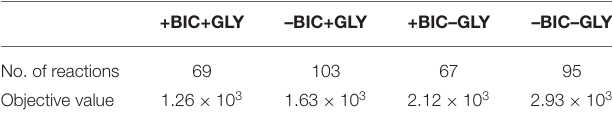
TABLE 1 | Objective value and number of reactions in linear programming solution for each condition.